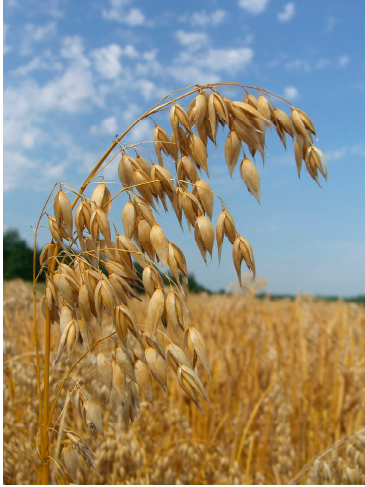
Figure 1. Oat panicle in an agricultural field.